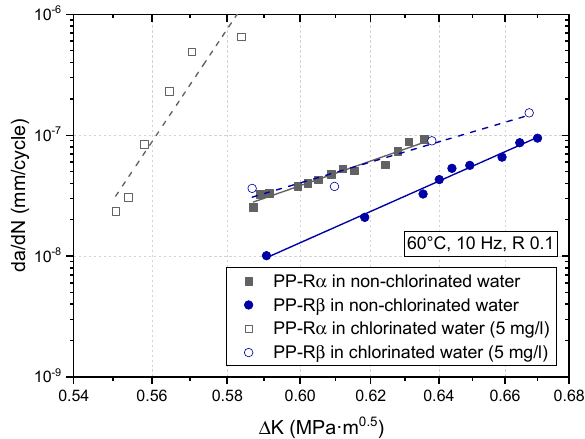
Figure 8. Crack growth curves of PP-R α and PP-R β tested at 60 °C in non-chlorinated water with 0 mg / L free chlorine and in chlorinated water with 5 mg / L free chlorine.